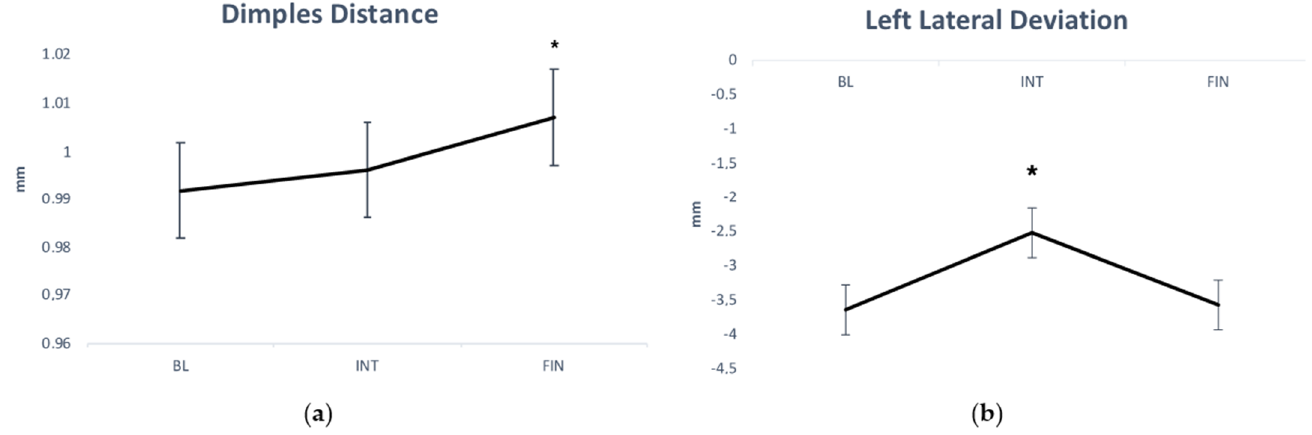
Figure 1. Variation in the dimples distance ( a ) and left lateral deviation ( b ) parameters across the three measurements. BL: baseline. INT: intermediate. FIN: final. *: p < 0.05 BL vs. FIN (panel a); p < 0.05 INT vs. BL and vs. FIN (panel b).